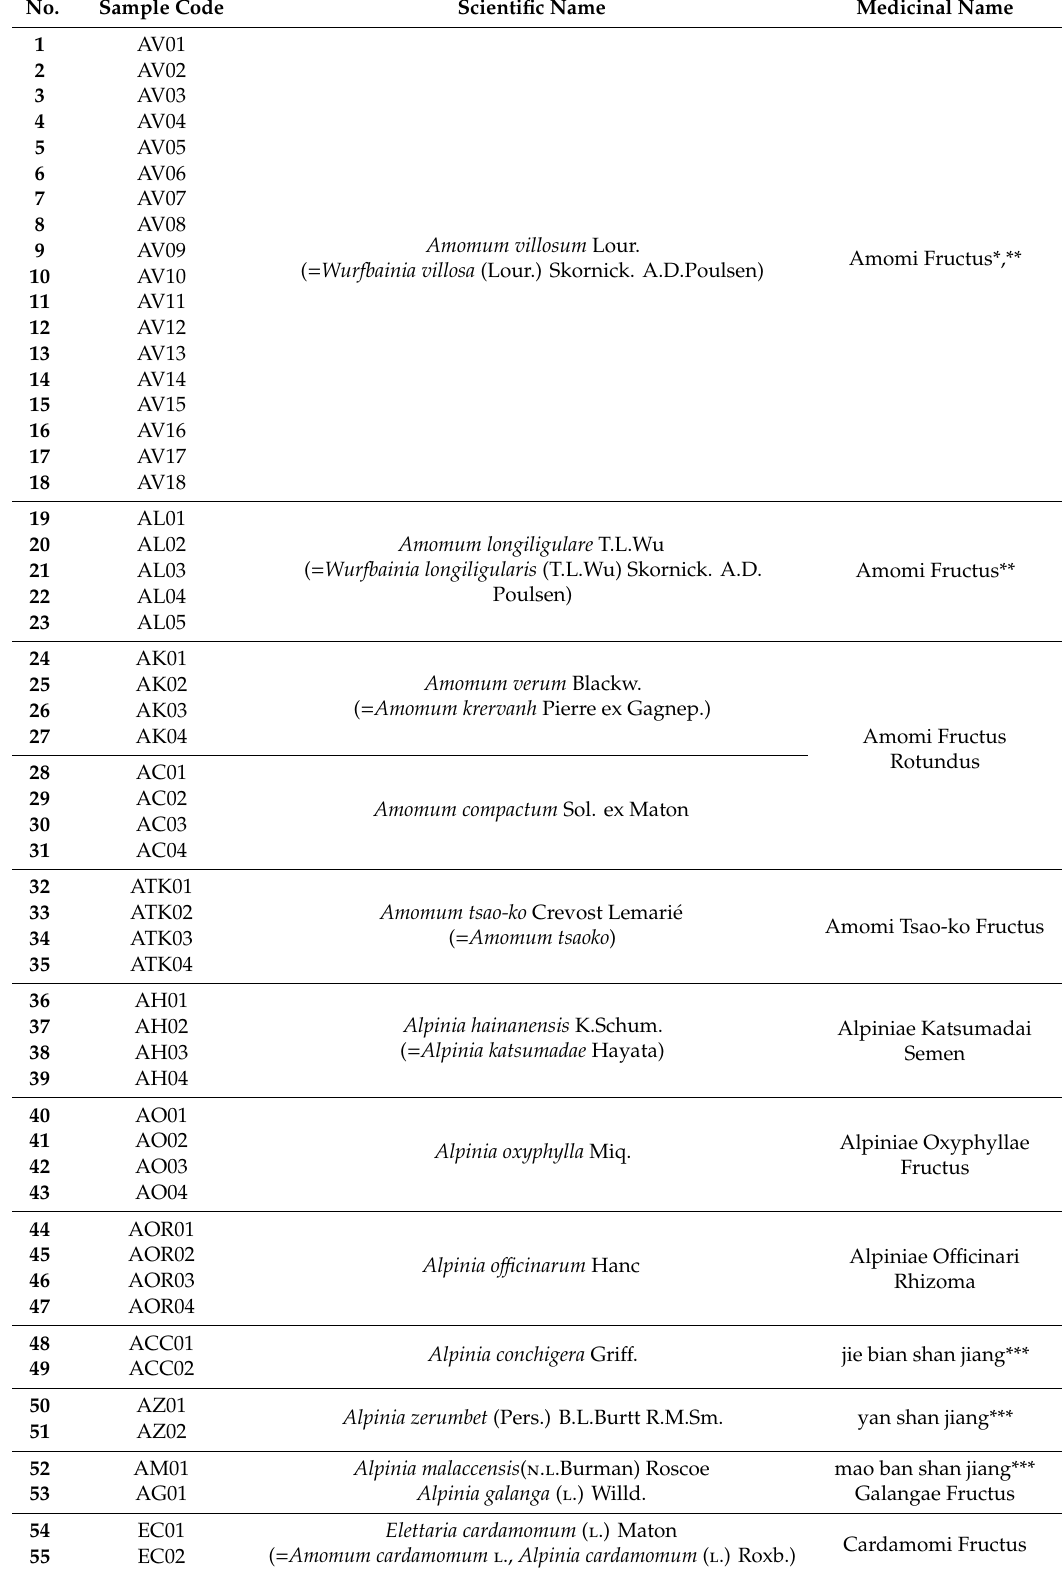
Table 1. The collected Amomi Fructus and Zingiberaceae plants samples used in this study.